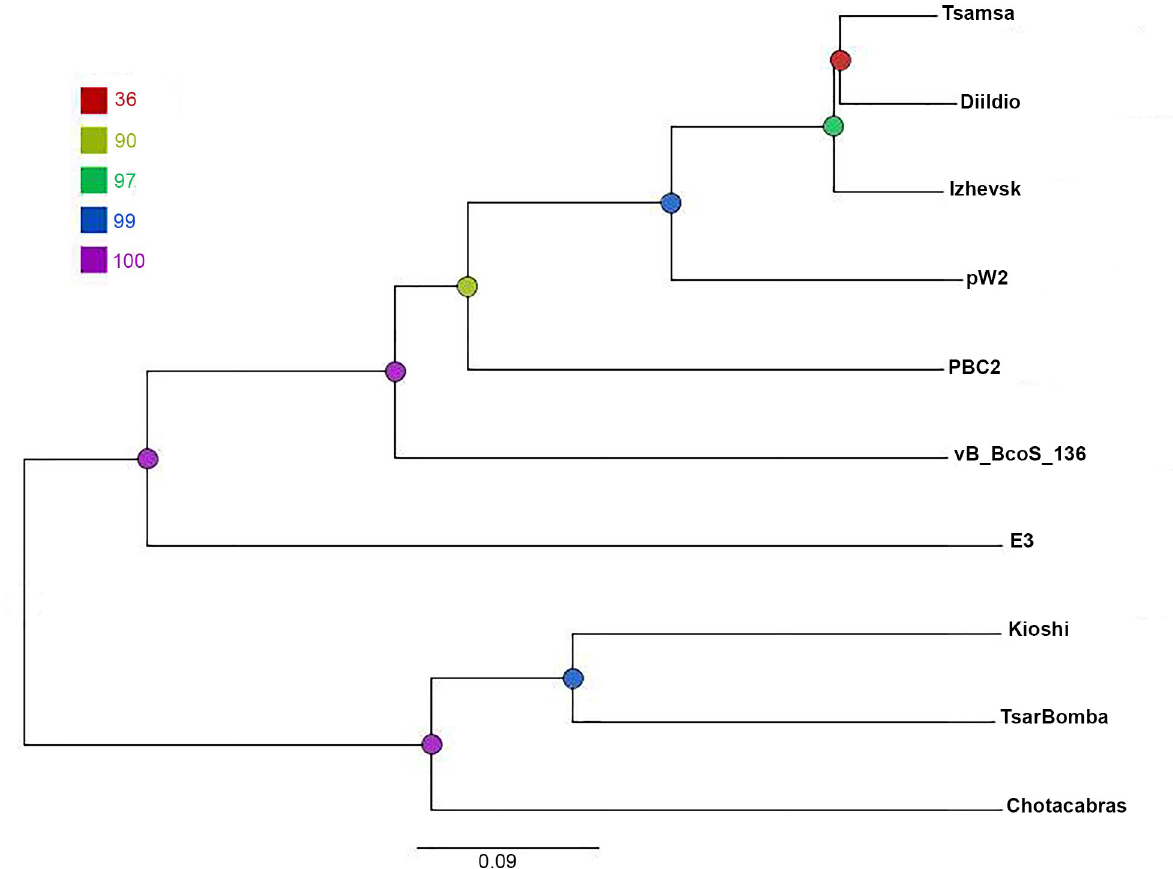
Fig 5. Genome-BLAST Distance Phylogeny (GBDP) phylogram based on the amino-acid sequences of whole proteomes and inferred using the formula D6. The nodes are colored according to the legend representing GBDP pseudo-bootstrap support values from 100 replications. The branch lengths are scaled in terms of the GBDP distance formula D6.